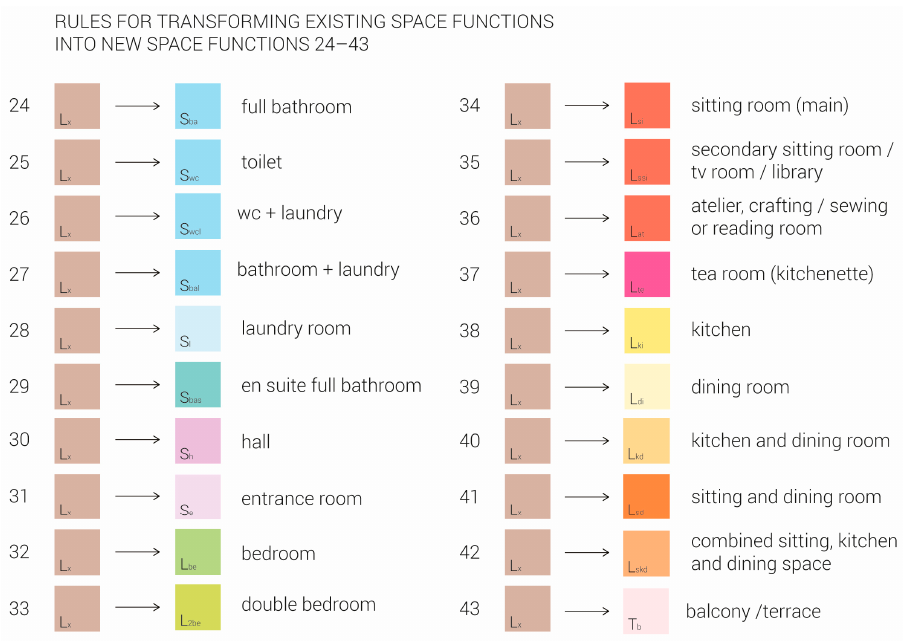
Figure 11. Rules for transforming existing space functions into new space functions 24–43 (Ana Bel č i č , 2022).